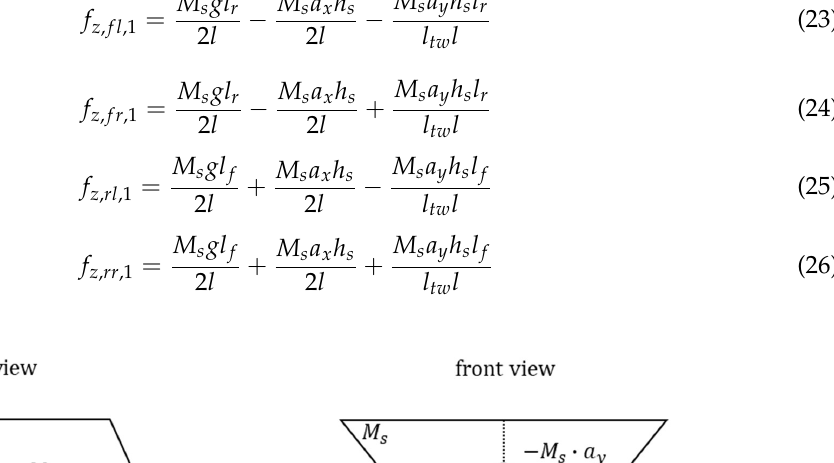
Figure 11. Vehicle normal force scheme. ( a ) Vehicle side view; ( b ) vehicle front view.